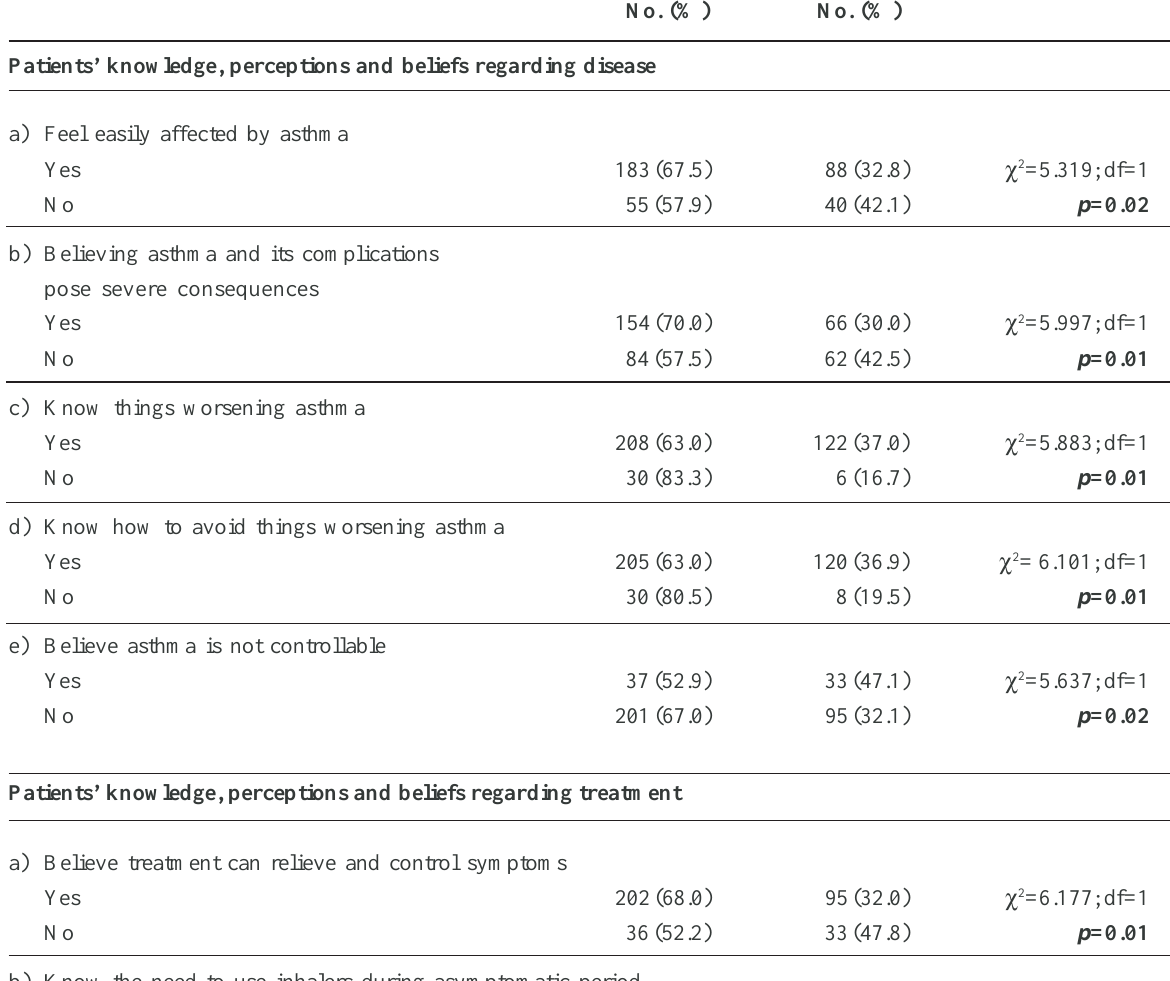
Table 3. Patients related factors associated with treatment compliance